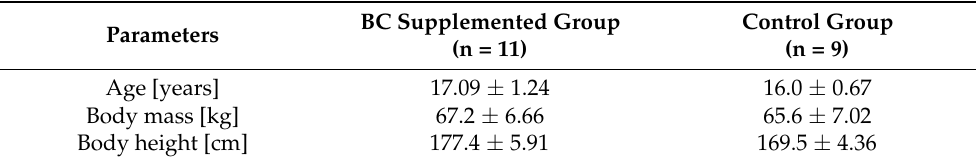
Table 1. Basic characteristics of the studied groups (mean ± standard